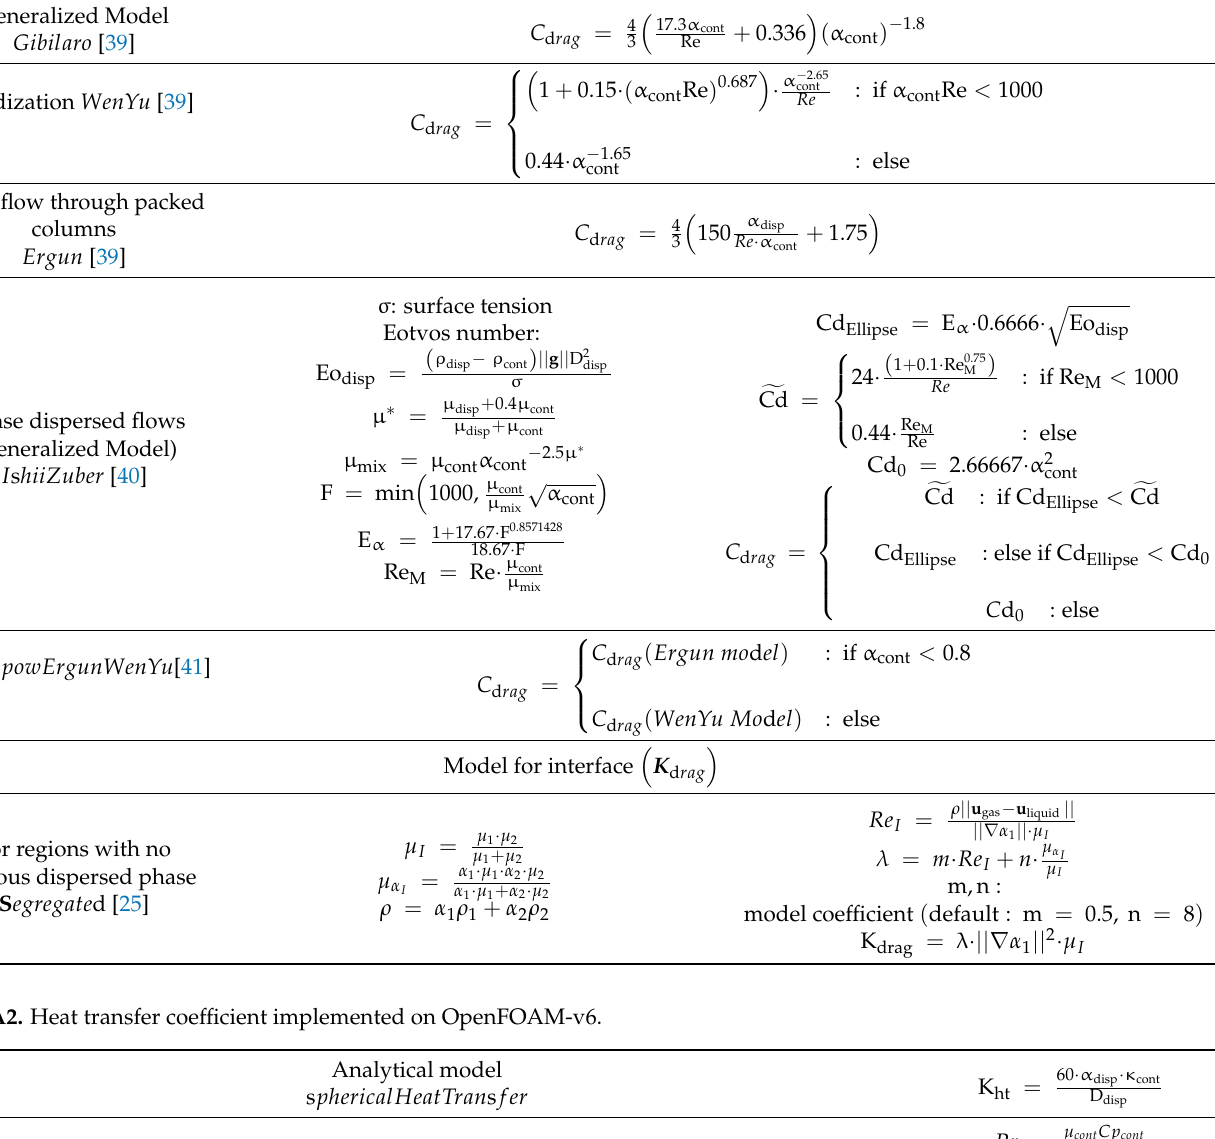
Table A1. Drag coefficient models implemented on OpenFOAM-v6 handling a dispersed liquid phase. Generalized Model